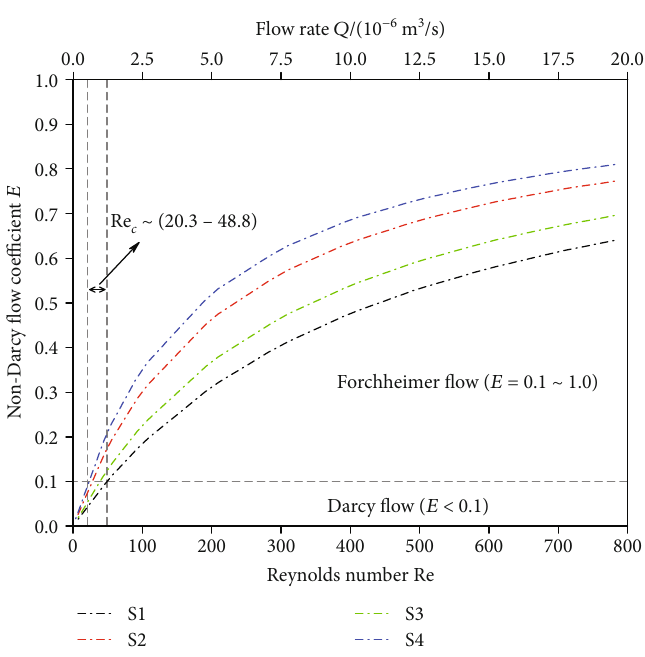
Figure 5: Variation of non-Darcy coe ffi cient of fracture surface for samples S1-S4.